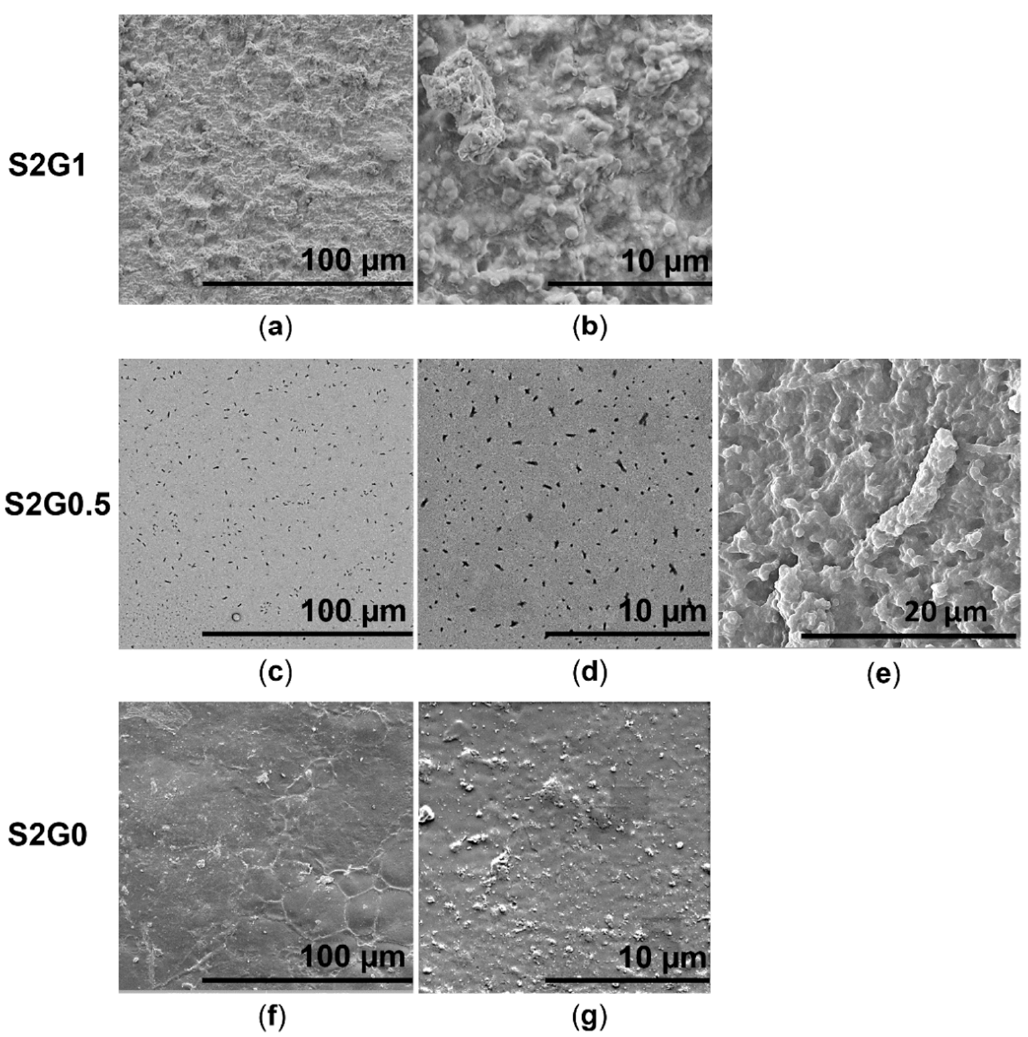
Figure 5. SEM images of hydrogels containing a different glycerin content: 0; 1.7 and 3.4% ( v/v ); ( a , b ) sample S2G1; ( c , d ) sample S2G0.5; ( e ) cross-section of sample S2G0.5; ( f , g ) sample S2G0.